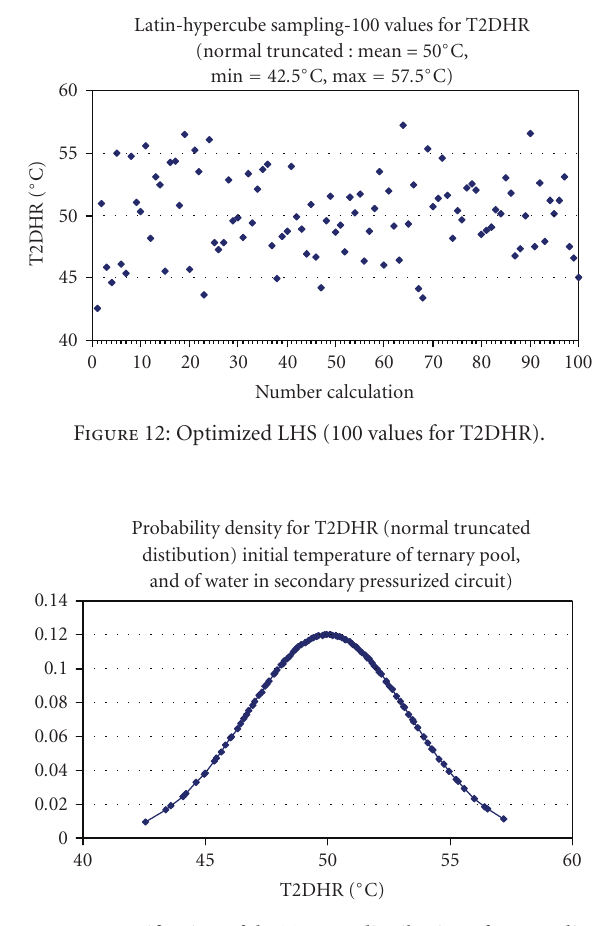
Figure 13: Verification of the T2DHR distribution after sampling.